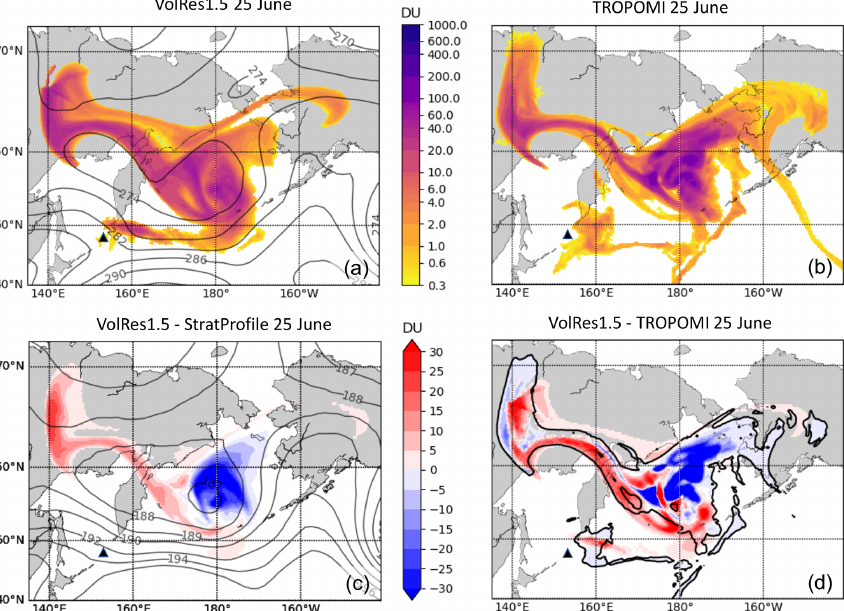
Figure 6. The spatial pattern of the volcanic cloud on 25 June 2019. The colours in panels (a) and (b) represent the SO 2 VCD for the VolRes1.5 simulation and TROPOMI retrievals respectively. The black contours in panel (a) show the pressure at 10kma.s.l. Panel (c) shows the difference between the VolRes1.5 and the StratProfile simulations, and the black contours show the pressure at 12kma.s.l. The negative (blue) values indicate the part of the cloud within the stratosphere, while the positive (red) values highlight the cloud within the UT. Panel (d) shows the difference between panels (a) and (b) , where the contour shows the 1DU contour for the SO 2 cloud retrieved by TROPOMI in panel (b) .